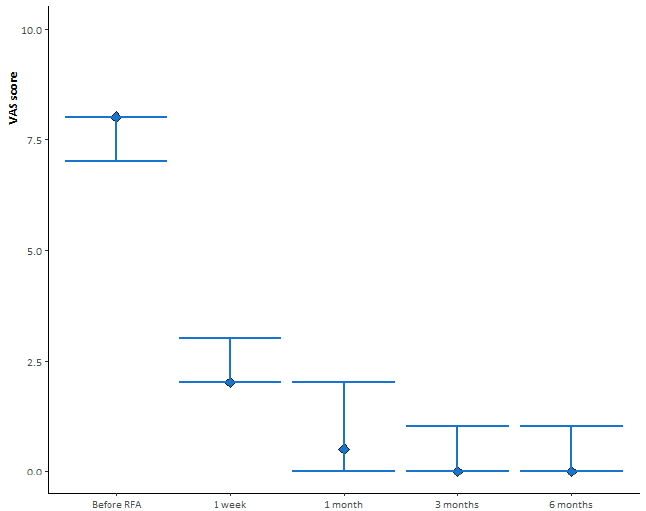
Figure 5. Median VAS score follow-up evaluated before and prospectively after 1 week, and 1, 3, and 6 months from the treatment.